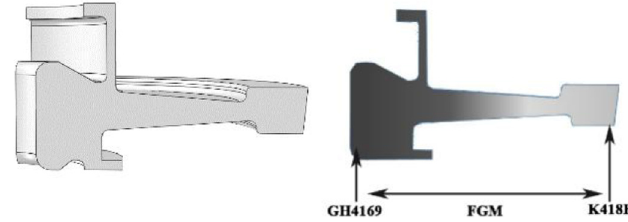
Fig. 4. Turbine disk model and material distribution.